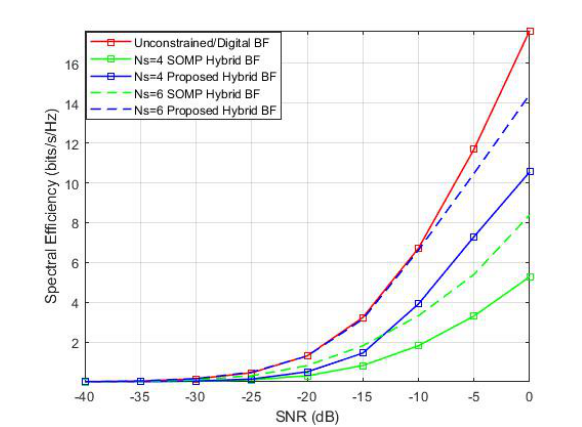
Fig. 14. BER performance for